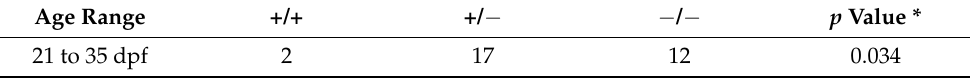
Table 2. Genotypes of dead animals collected from heterozygous crossings between 21- to